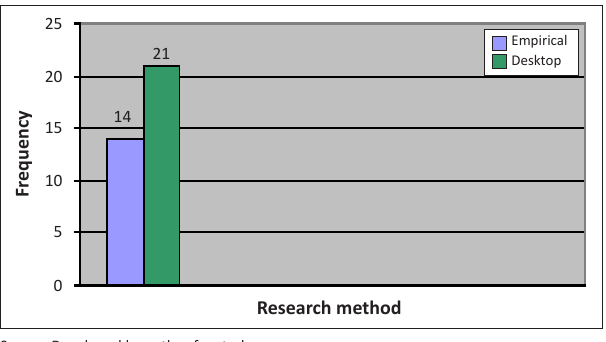
FIGURE 2: Distribution of papers according to research